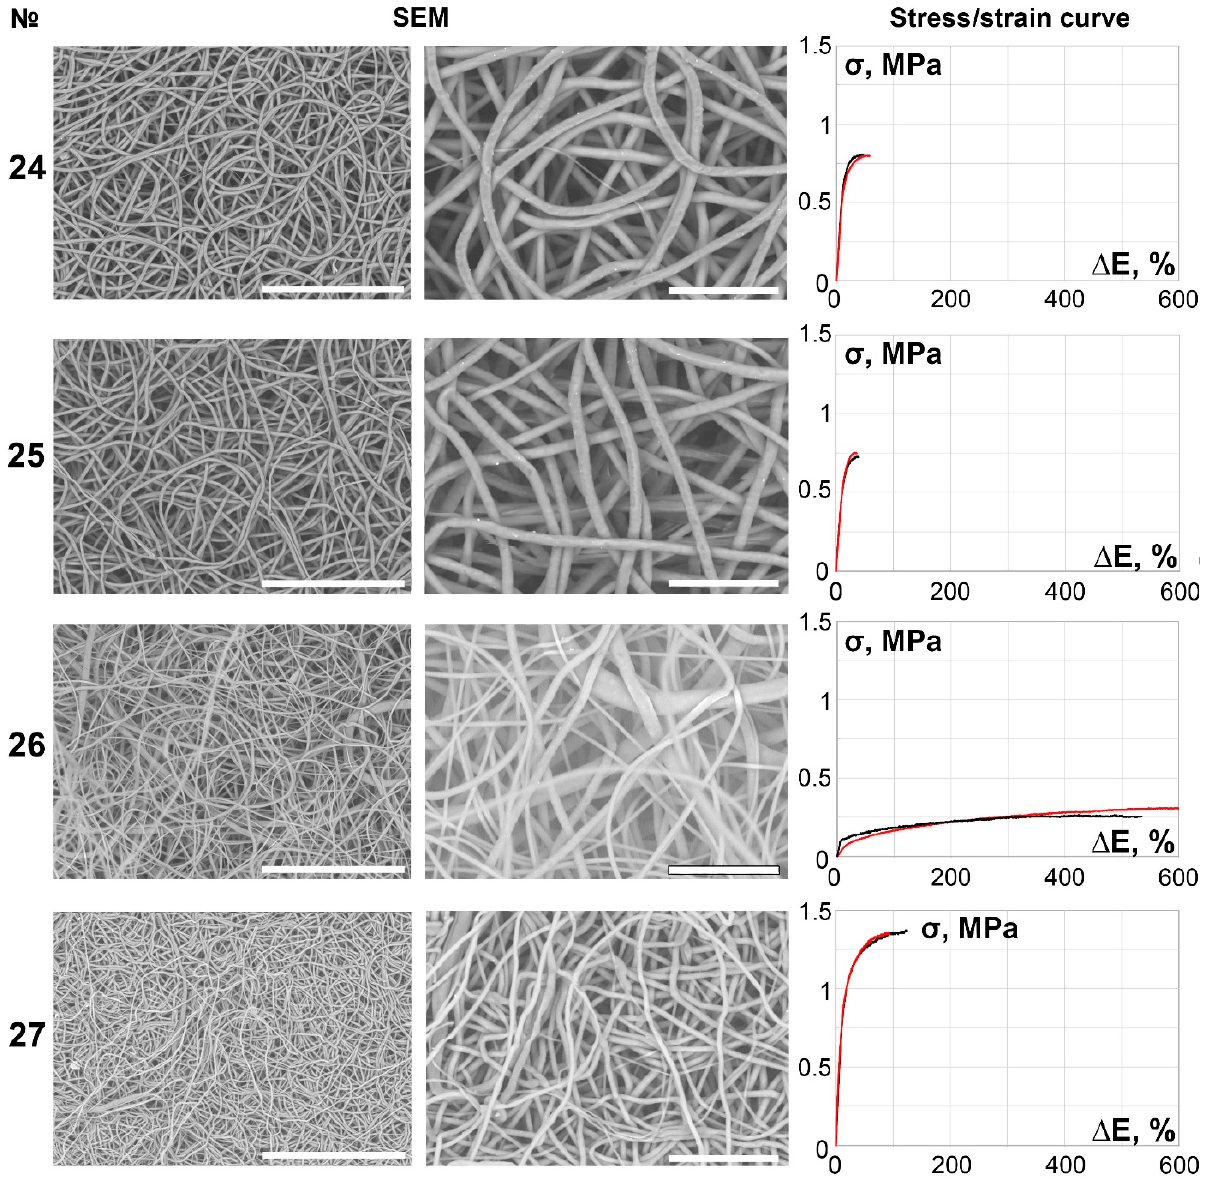
Figure 6. SEM images ( × 250 magnification, scale bar 200 µ m and × 700 magnification, scale bar 50 µ m) and stress/strain curves of tested 16% PCL samples. Red curves reflect stress/strain plotting in the axial direction; black curves correspond to circumferential stretching.